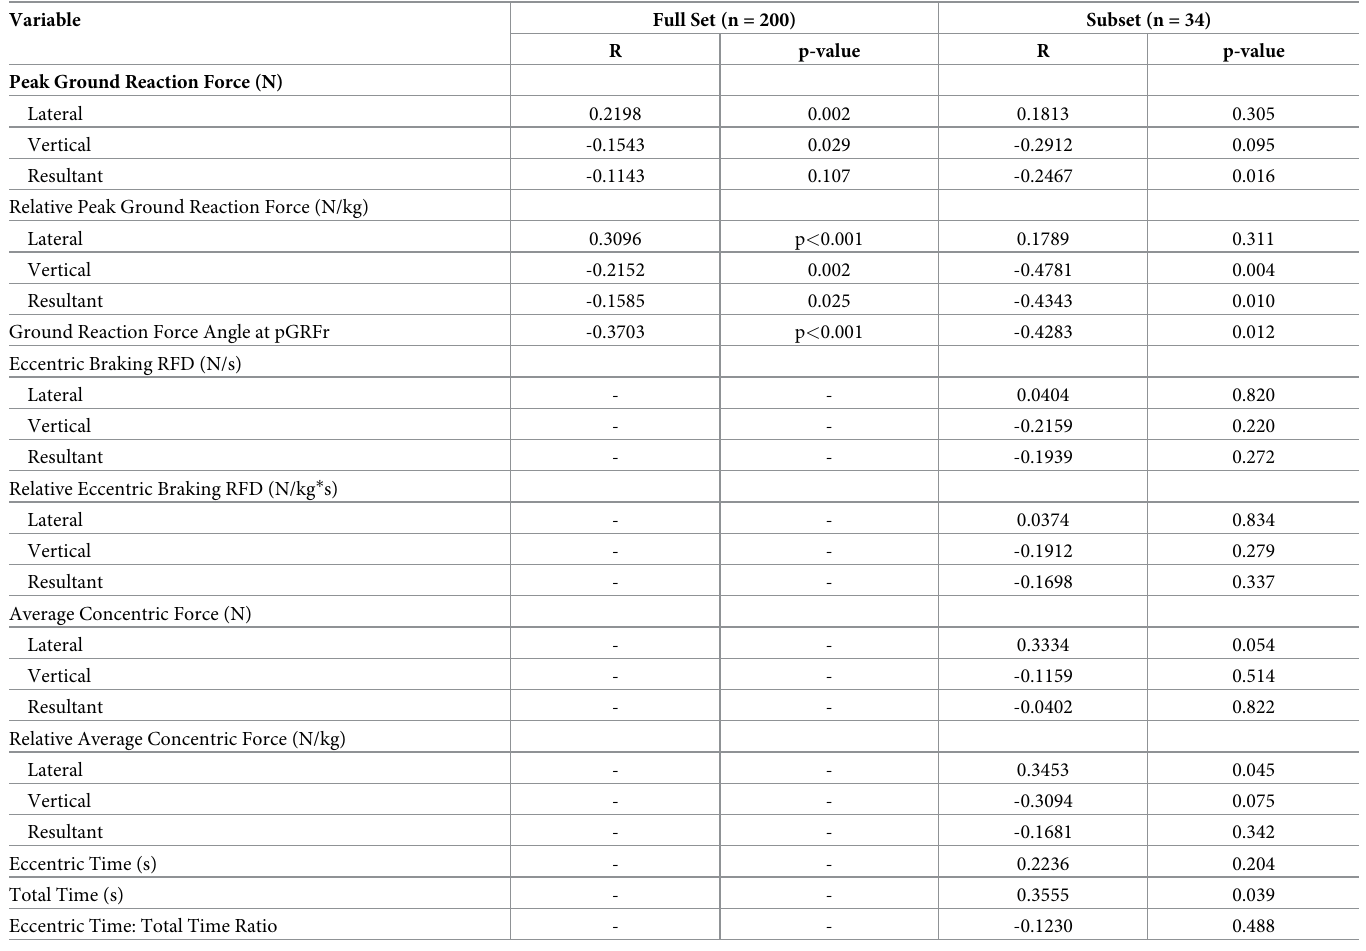
Table 2. Pairwise correlations between the response variable (jump distance) and the predictor variables.